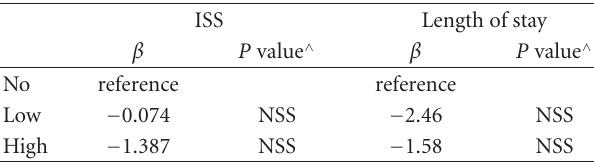
Table 4: Adjusted coe ffi cients of blood alcohol level for ISS and length of stay.